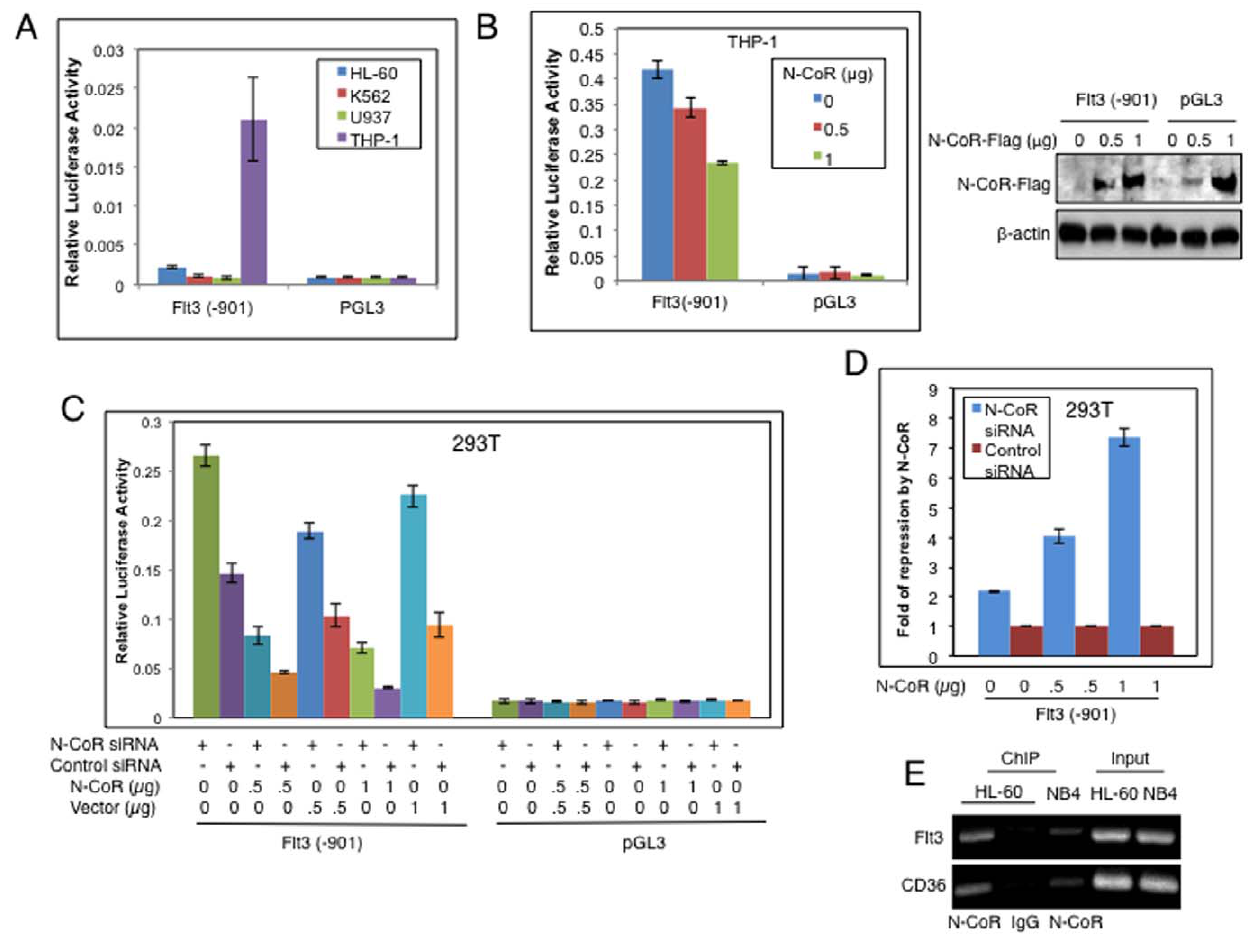
Figure 3. Repression of Flt3 by N-CoR protein. A , Relative activity of a luciferase reporter driven by the Flt3 promoter was determined in various leukemic cell lines. The cells were transfected with reporter and reference plasmids using electroporation. The values presented in each bar represent the average of three independent experiments. B , Effect of ectopic N-CoR on the activity of the Flt3 promoter in THP-1 cells electroporated with Flag- tagged N-CoR plasmid in a dose dependent manner was determined via luciferase assay (left panel). The values presented in each bar represent the average of three independent experiments. In parallel, levels of ectopic N-CoR protein in THP-1 cells used in the luciferase assay were determined in western blotting assay with anti-Flag antibody (right panel). C , Effect of ectopic N-CoR on the activity of the Flt3 promoter in 293T cells transfected with N-CoR or control siRNA was determined using luciferase assay. In pGL3-Flt3 ( 2 901) reporter plasmid, luciferase reporter was placed under the control of the full length Flt3 promoter. The values presented in each bar represent the average of three independent experiments. D , The dose dependent fold repression by ectopic N-CoR in N-CoR ablated or non-ablated 293T cells was calculated by dividing the mean relative luciferase activity in N-CoR siRNA transfected cells with that of control siRNA transfected cells of Fig. 3C. E , N-CoR is associated with the Flt3 promoter. Relative amounts of Flt3 promoter sequence associated with N-CoR protein in HL-60 or NB4 cells were determined through ChIP assay. The antibody used in the ChIP assay is mentioned at the bottom. N-CoR association with CD36 promoter, a known N-CoR target gene, was determined as positive